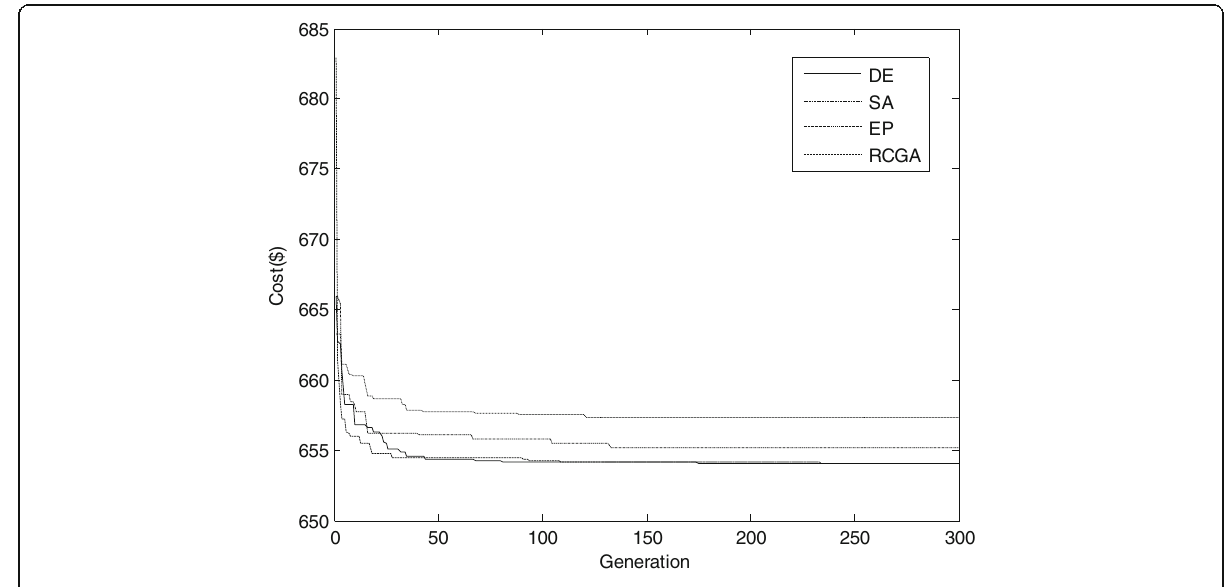
Fig. 2 Cost convergence characteristic of test system